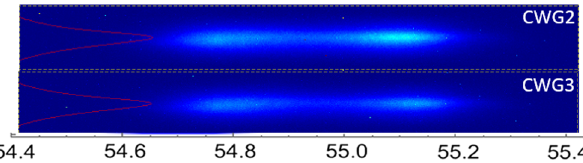
FIG. 17. The diagnostics screen images taken when the electron bunch propagated the CWG2 with L ¼ 93 mm and the CWG3 with L ¼ 100